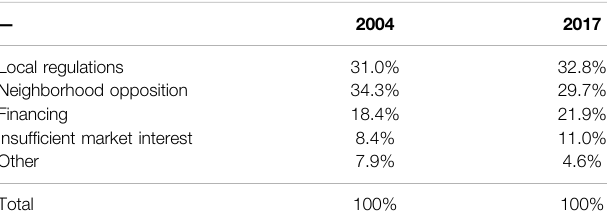
TABLE 14 | Changes of percent of second most signi fi cant challenges encountered from 2004 to 2017.